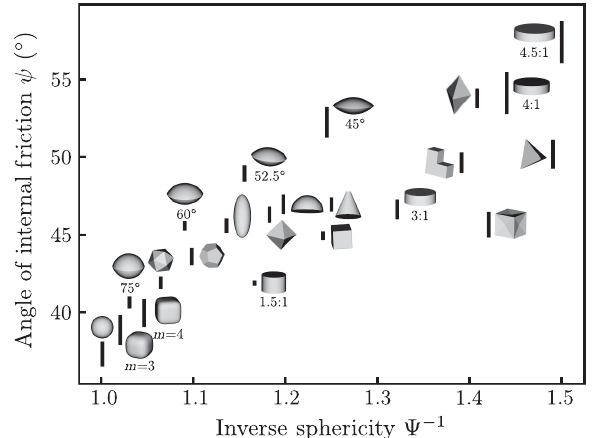
FIG. 4. Shear strength versus deviations from a sphere. The angle of internal friction data from Fig. 3 are plotted against the inverse of sphericity. As a measure of the compactness, sphericity is calculated as the ratio of a particle ’ s surface area to that of a sphere with the same